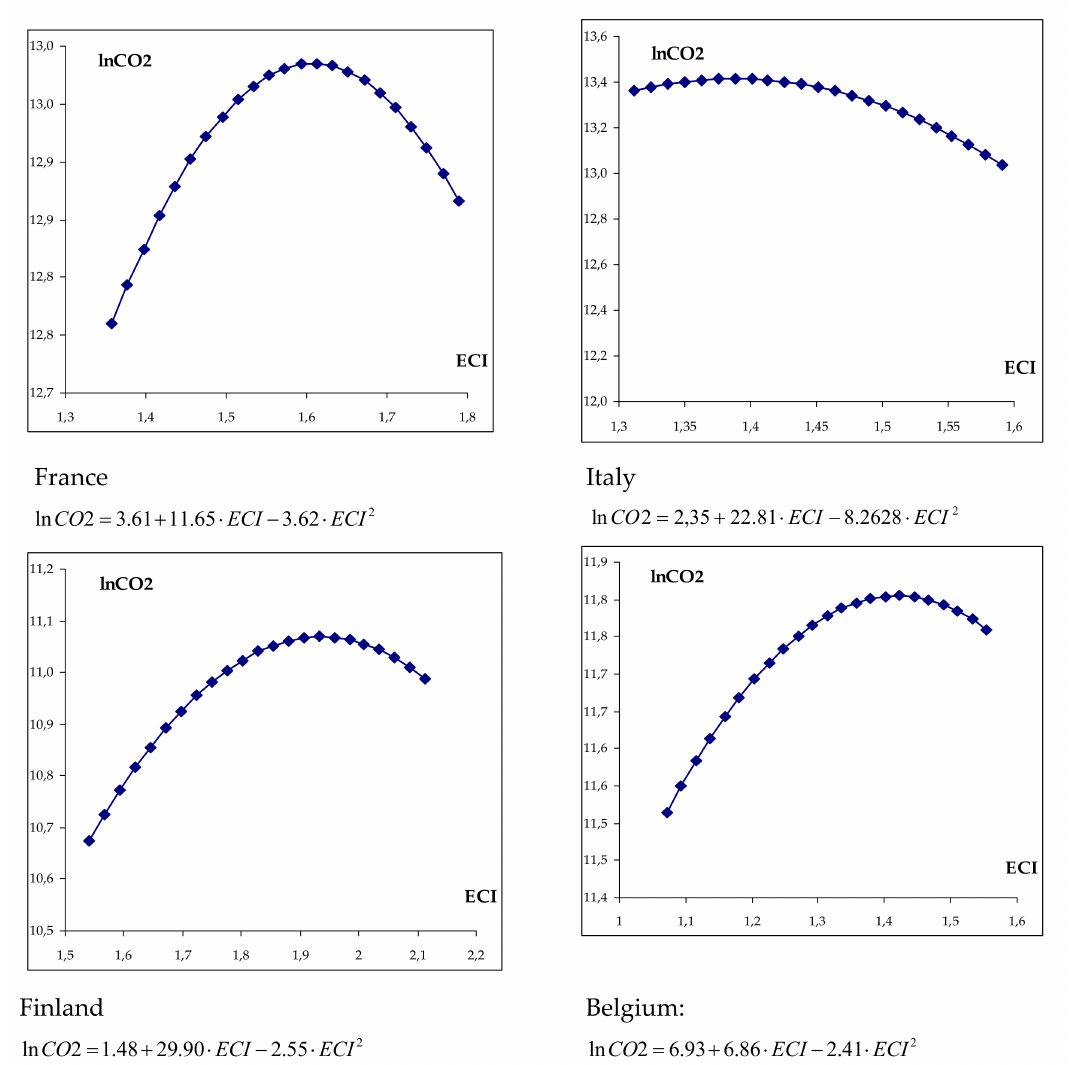
Figure 2. The estimated EKC model in some European countries using ECI as explanatory variable (1995–2017). Reprinted with permission from Ref. [57]. Copyright: © 2021 by the author. Licensee MDPI, Basel,